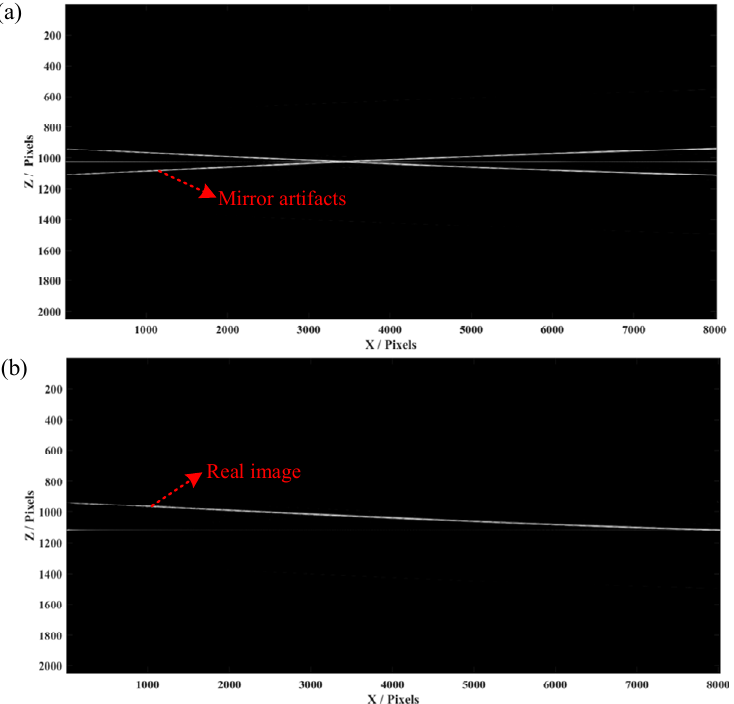
Figure 4. The experimental results of a mirror. ( a ) The conventional OCT image with 2048 full pixels in depth. ( b ) The FROCT image reconstructed by our proposed method using a voice coil motor.